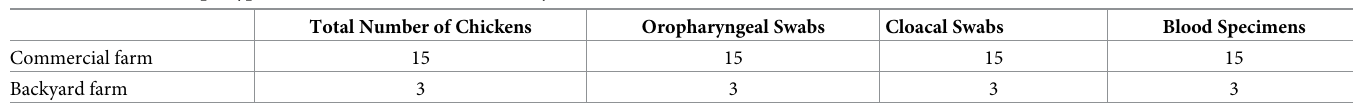
Table 1. Collected sample types from each commercial and backyard farm. Total Number of Chickens Cloacal